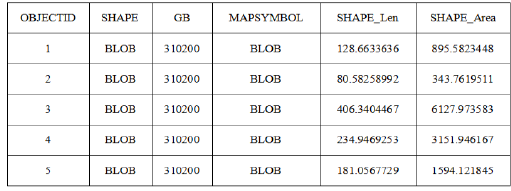
Figure 4. The structure of DLGM in extended DLG